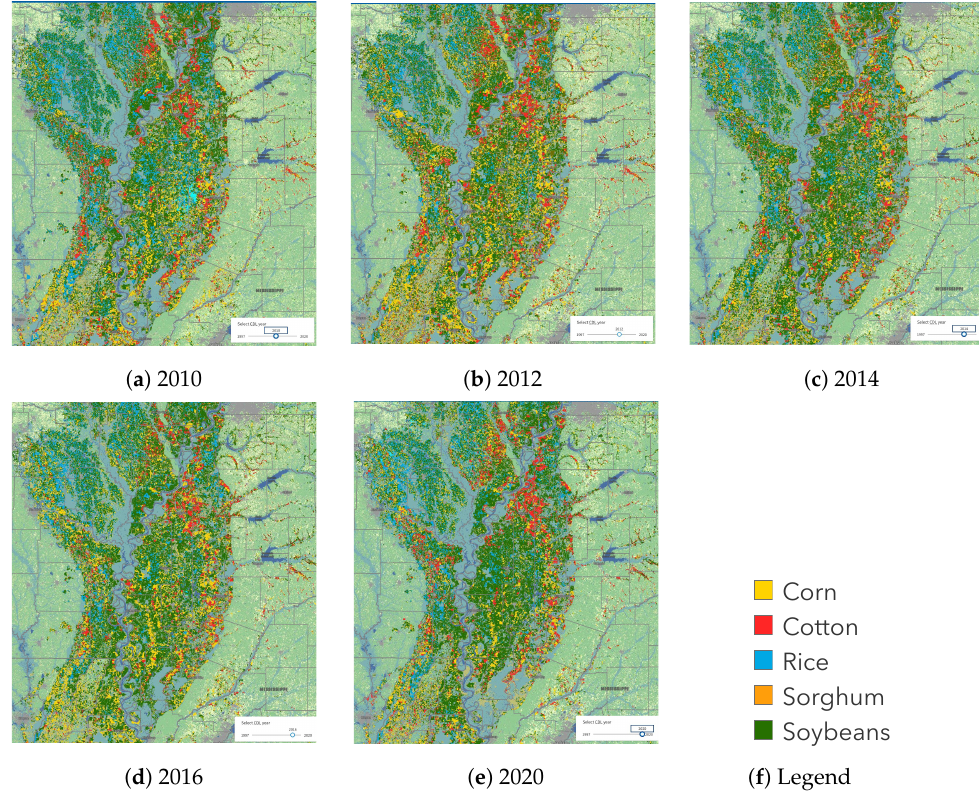
Figure 2. Evolution of cropping landscape in Mississippi